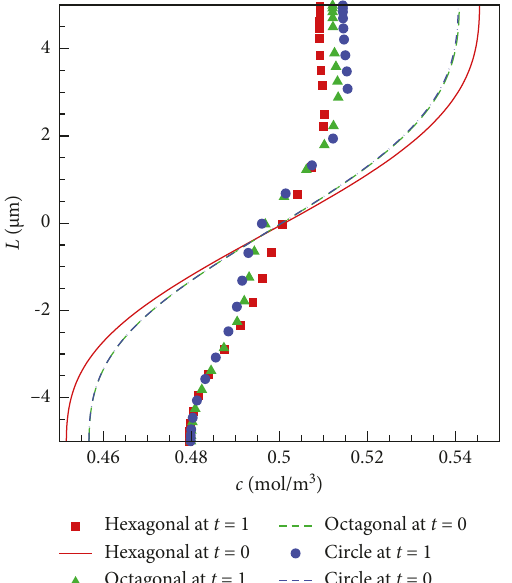
Figure 14: Variation of concentration based on the changes in length in 3 different mixing chambers when u � 0 . 1 [ mm / s ] , φ � π /2 and f � 10 [ Hz ] at different times.